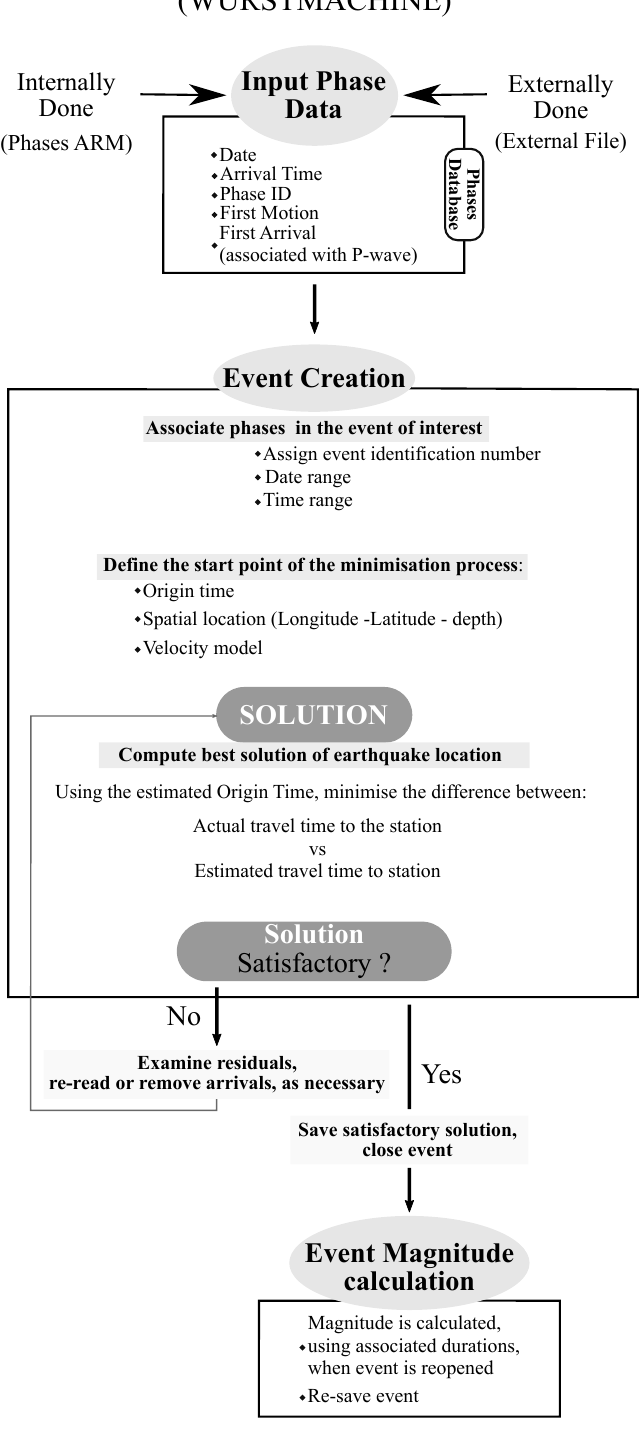
Figure 3. Flow chart of the UWI-SRC seismic data processing system performed with the WurstMachine